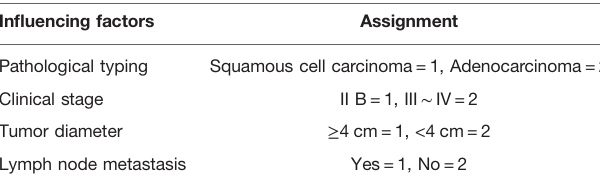
TABLE 4 | Assignment table.